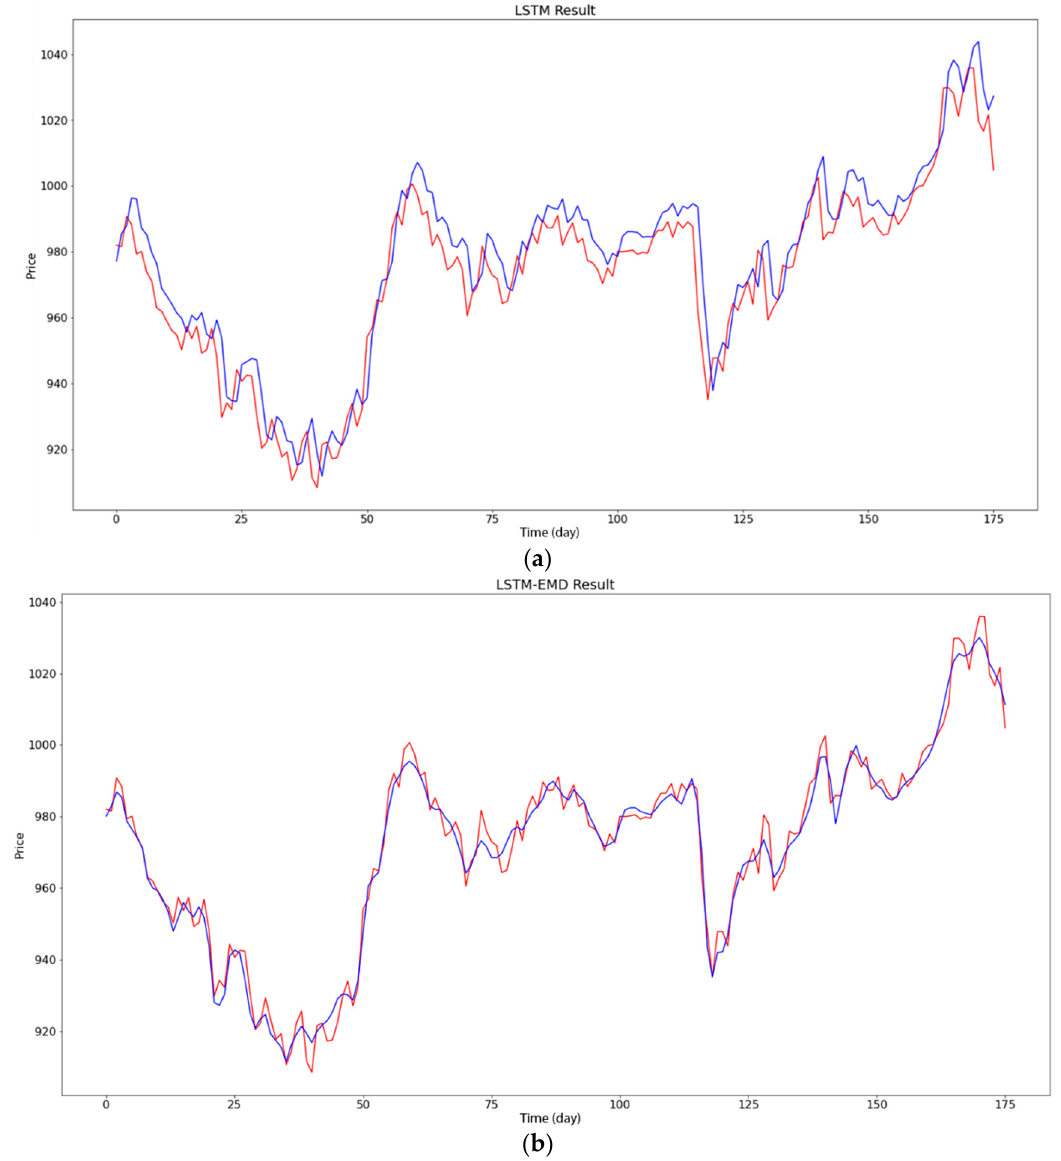
Figure 8. Results of stock price prediction from LSTM ( a ) and LSTM-EMD ( b ).